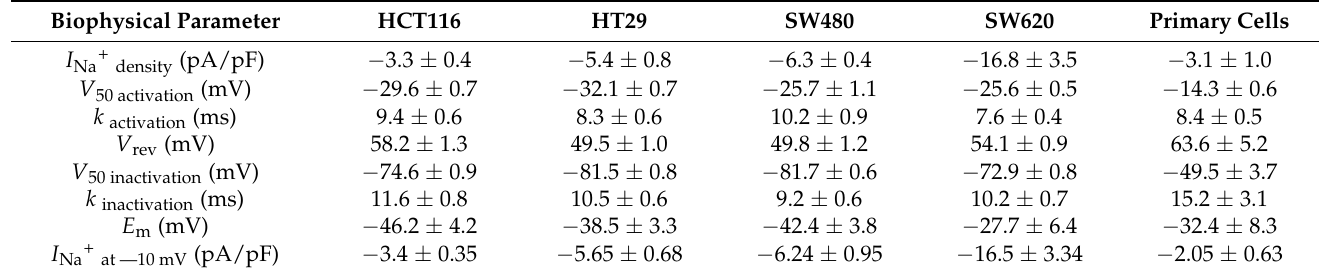
Table 1. Voltage parameters of Na V 1.5 sodium channels recorded in human colon cancer